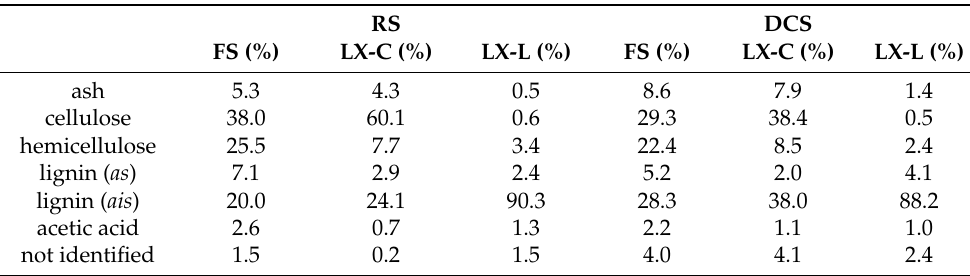
Table 1. Lignocellulose composition of raw and LX-pretreated RS and DCS (FS = feedstock, as = acid soluble, ais = acid insoluble, LX-C = LX-Cellulose, LX-L = LX-Lignin) 1 . RS DCS FS (%) LX-C (%) LX-L